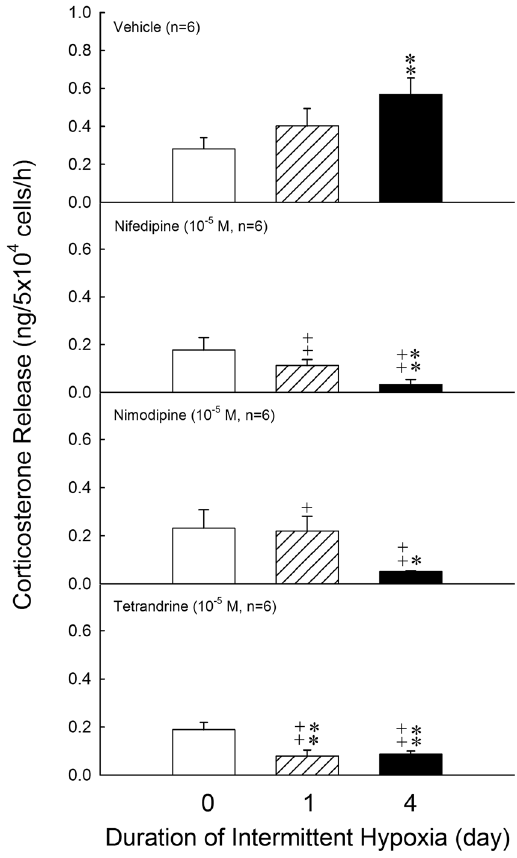
Figure 3. Effects of hypoxia on the activity of calcium channel associated corticosterone release in ZFR cells. * P < 0.05, ** P < 0.01 compared to normoxia (control) group. + P < 0.05, ++ P < 0.01 compared to calcium blocker. Each value represents the mean ±